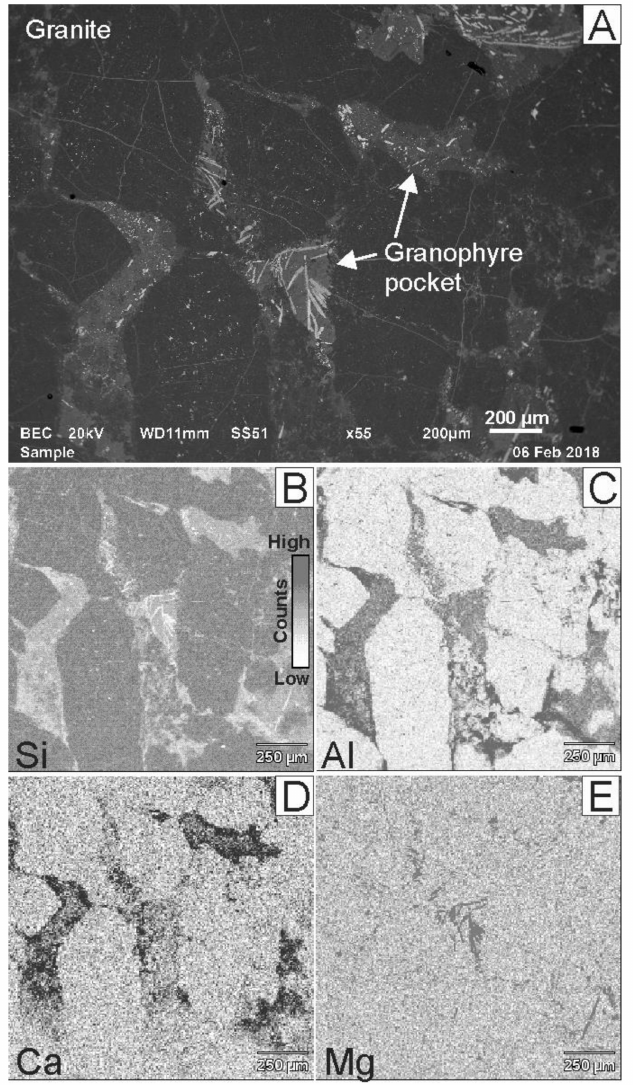
Figure 6. BSE image and EDX maps of the granite clast with pockets of granophyre. ( A ) BSE image. ( B ) EDX intensity map of Si, showing that the granophyre is depleted in Si compared to the granite clast. ( C ) EDX intensity map of Al, showing that the granophyre is enriched in Al. ( D ) EDX intensity map of Ca, showing that the granophyre is enriched in Ca. ( E ) EDX intensity map of Mg, showing that the granophyre is enriched in Mg within the pyroxene